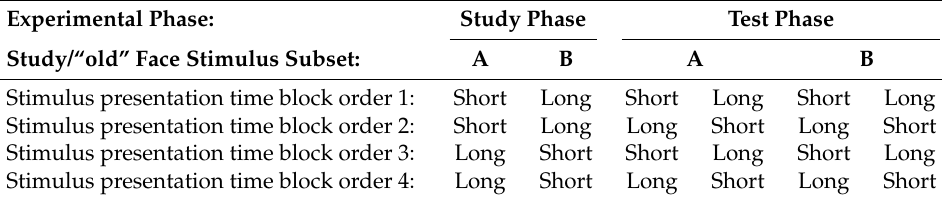
Figure 2. Schematic of the experimental trial sequences. Participants initiated trials with a button press, and following a brief and enforced central fixation, the facial stimulus appeared to the left or right. In Study phase trials, each facial stimulus was displayed for either one or five seconds total, depending on the block. In the Test phase, facial stimuli appeared for up to either 1 or 5 s, depending on the block, and within five seconds of stimulus onset, participants were required to respond whether the face had been in the Study phase or not (i.e., whether the face was “old” or “new”). The order of the short and long stimulus presentation blocks within the study phase was counterbalanced across participants. The “old” faces in the first two blocks of the test phase were those faces contained within the first block of the study phase, and likewise the “old” faces in the last two blocks of the test phase were those contained within the second block of the study phase. Within the test phase, the short and long stimulus presentation blocks alternated and their order across participants was counterbalanced between the two possible orders for the study phase blocks. Thus, with respect to short and long stimulus presentation time, there were four possible combinations of study and test phase block orders (Table 1). Table 1. Outline of the experimental paradigm and counterbalancing of stimulus presentation time blocks. The order of the experimental phases (top row) was the same for all participants. All of the “old” faces in the first two blocks of the test phase were the same set of faces contained within the first block of the study phase (indicated by ‘A’ in the second row). Likewise for the “old” faces in the last two blocks of the test phase and the second block of the study phase (indicated by ‘B’ in the second row). ‘A’ and ‘B’ refer to arbitrary stimulus subsets that differed pseudorandomly across participants. The order of the stimulus presentation time conditions of the blocks was psuedorandomized across participants (last four rows).